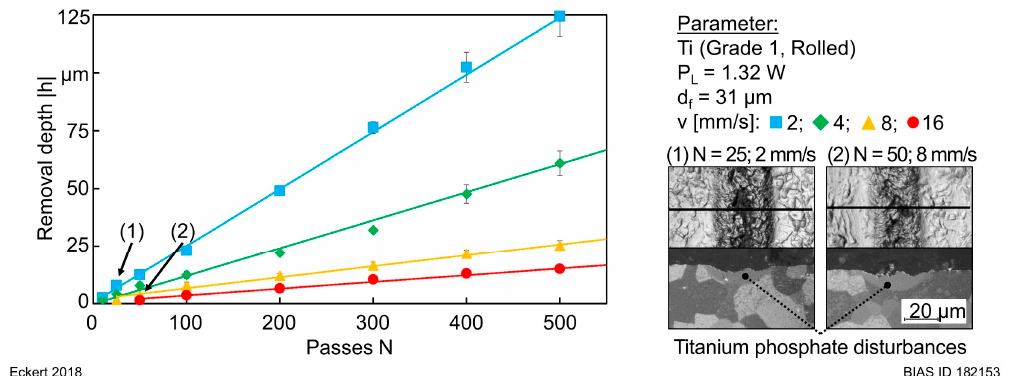
Figure 4. Removal depth over number of passes for different scan velocities.